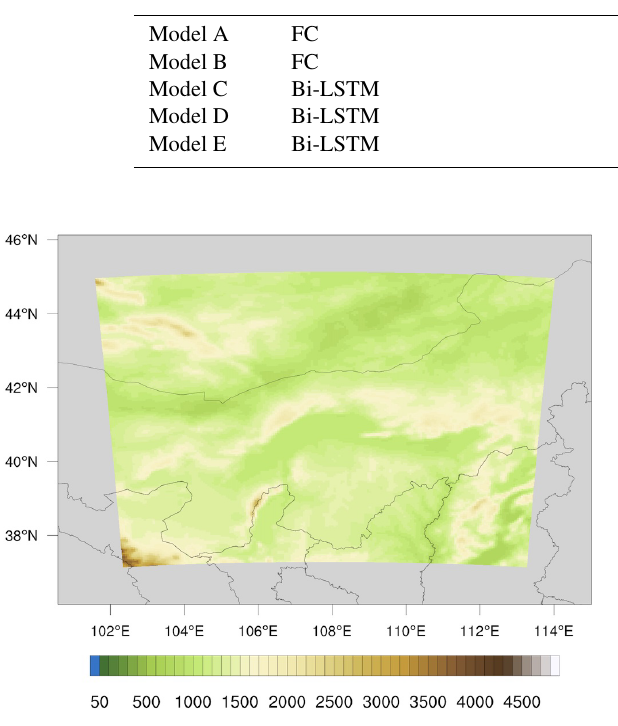
Figure 5. Digital evaluation data of the single WRF domain with horizontal resolution at 5km.